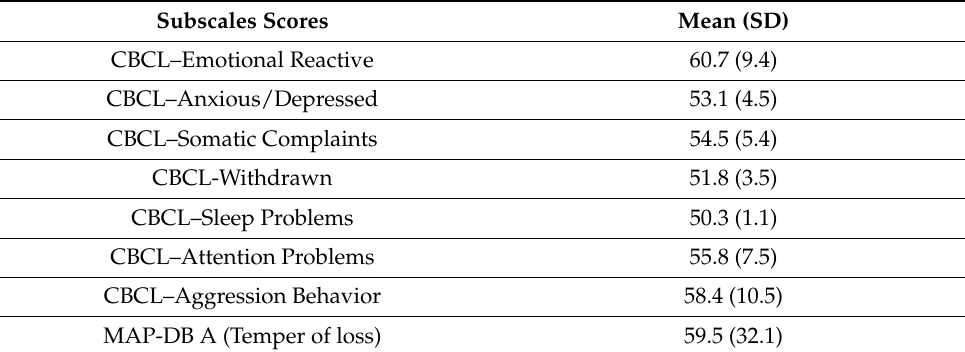
Table 2. Descriptive statistics for the MAP-DB’s “Temper Loss” scale and seven subscales of the CBCL/1 1 –5 (N = 400). 2